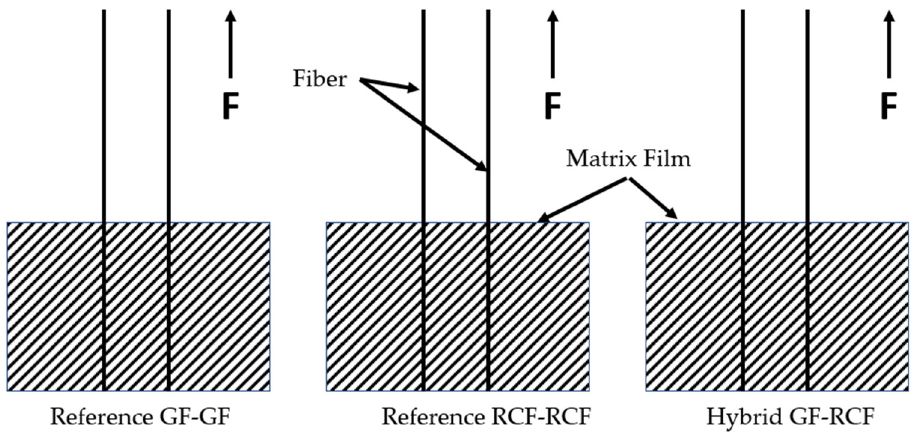
Figure 3. Schematic representation of the reference specimens and the hybrid fiber-reinforced specimen for fiber pull-out.